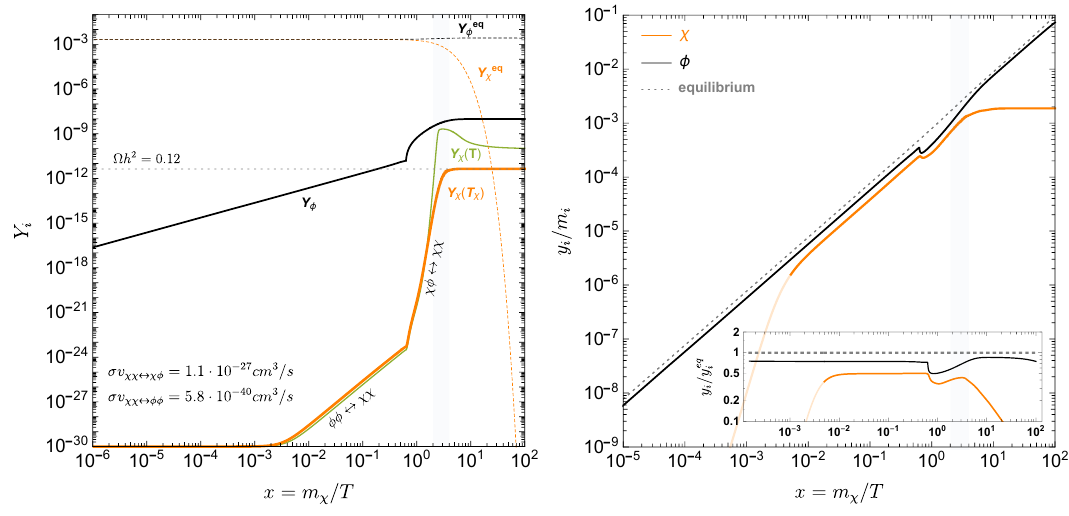
Figure 2 . The evolution of χ and φ number densities (left) and temperatures (right) for a bench- mark point with m χ = 100 GeV, µ φ = 1 GeV, λ 1 = 1 . 1 × 10 − 2 , λ 2 = 10 − 8 , λ hφ = 6 × 10 − 11 and θ = 10 − 5 , which makes semi-production the dominant process. Left : the solid lines show the evolution of Y φ (black), Y χ (orange) and Y χ ( T χ = T ) (green), while the dotted correspond to their equilibrium values. The process specified below the orange line highlights the dominant production channel in a given regime. Right : in the main plot the solid lines show the evolution of y φ (black) and y χ (orange), while in the inset plot their ratio to the equilibrium value is shown. The part of the orange line with lighter shading shows the regime where no significant population has yet been produced. In all of the plots the light gray shaded region depicts the time window in which the production of χ is most